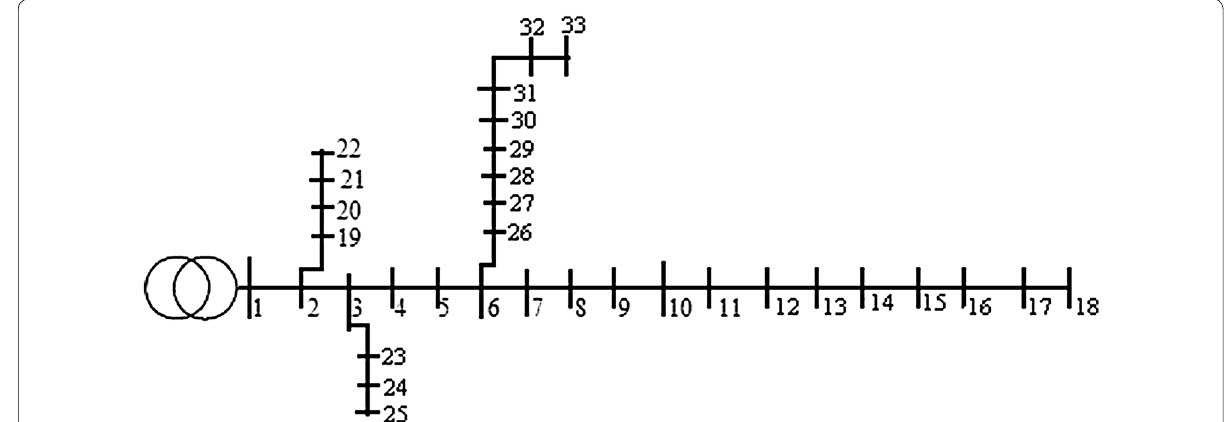
Fig. 2 Single line diagram of 33-bus system